Question: Write a single sentence explaining what this figure depicts.
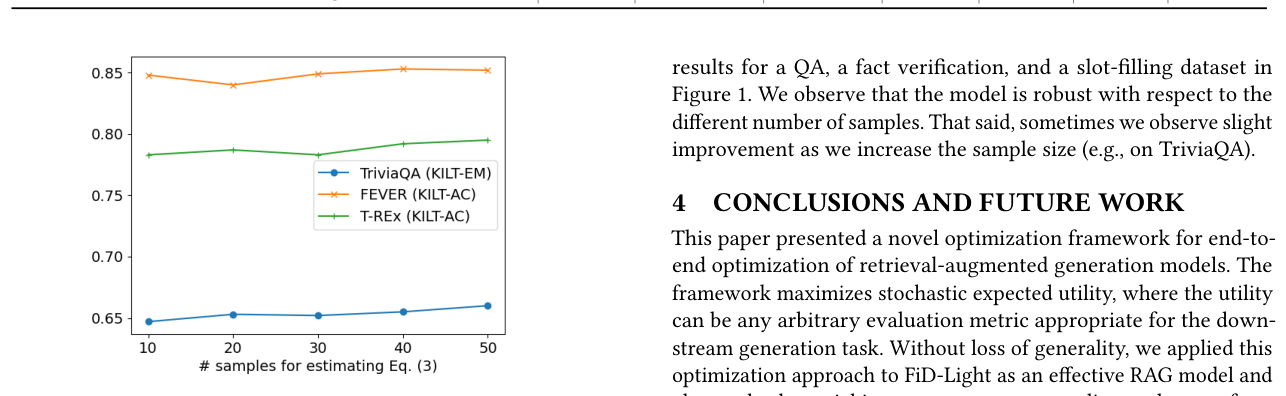
Answer: Sensitivity of Stochastic RAG with FiD-Light XL to the number of samples for estimating Equation (3).